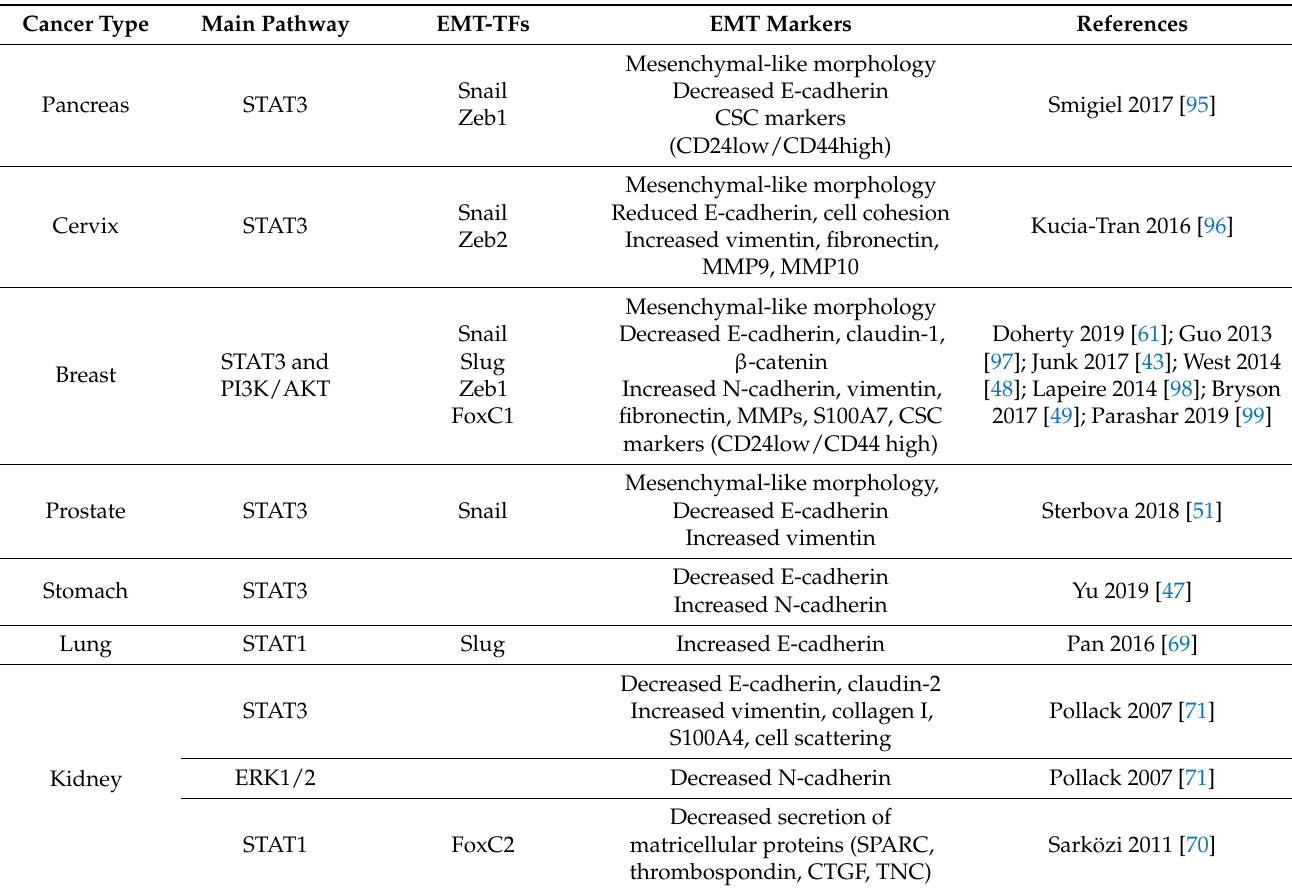
Table 2. Experimental evidence of the implication of oncostatin M (OSM) on epithelial–mesenchymal plasticity (EMP) in